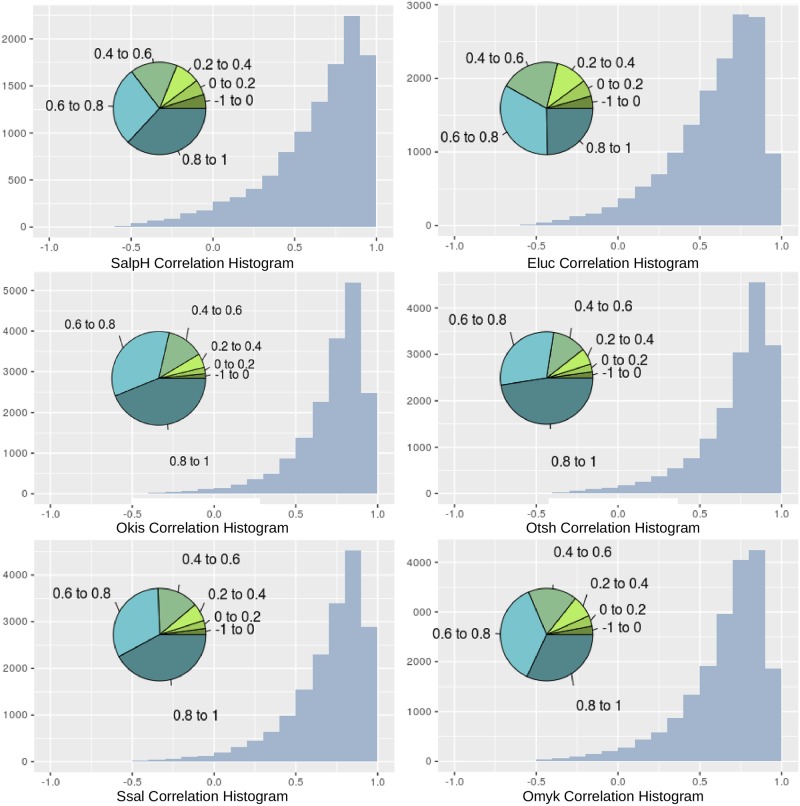
Histograms of correlation coefficients found between Arctic charr orthologs and other species.Each histogram also has a pie diagram to illustrate the frequency of a range of correlation values. Each histogram is labeled for the species that was compared to the Arctic charr orthologs (SalpH—11,035 homeologous genes, Eluc—15,428 orthologous northern pike genes, Okis—17,490 orthologous coho salmon genes, Otsh—16,320 orthologous Chinook salmon genes, Ssal—17,617 orthologous Atlantic salmon genes, Omyk—19,122 orthologous rainbow trout genes).